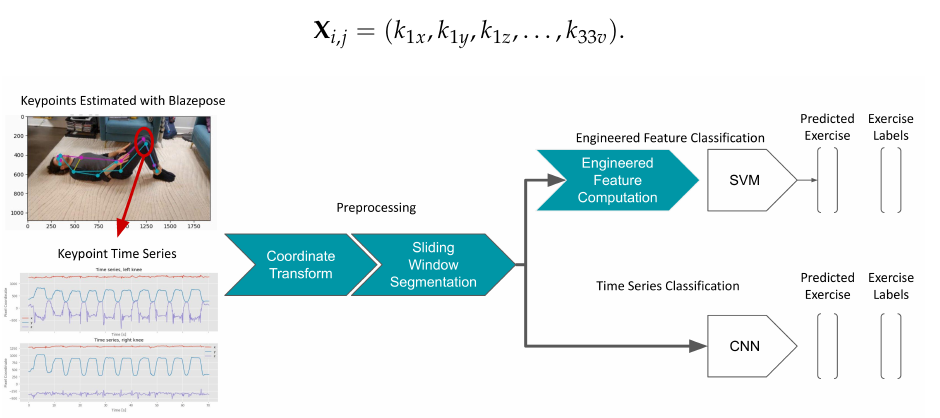
Figure 1. The design of the proposed platform. Subjects are filmed with a single camera using a smartphone while performing physiotherapy exercises. Joint keypoints are estimated for each video frame using BlazePose, resulting in a timeseries of keypoint coordinates for each video. A coordinate transform is applied to the keypoint timeseries in addition to sliding window segmentation. The keypoint time series segments are then used to train and evaluate a convolutional neural network (CNN). As a baseline comparison, engineered features are computed for each time series segment and used to train a support vector machine (SVM). Both models are trained to predict the physiotherapy exercise being performed in the given segment (seven-class classification). This process was performed for shoulder activities (Table A1) and again for low-back activities (Table